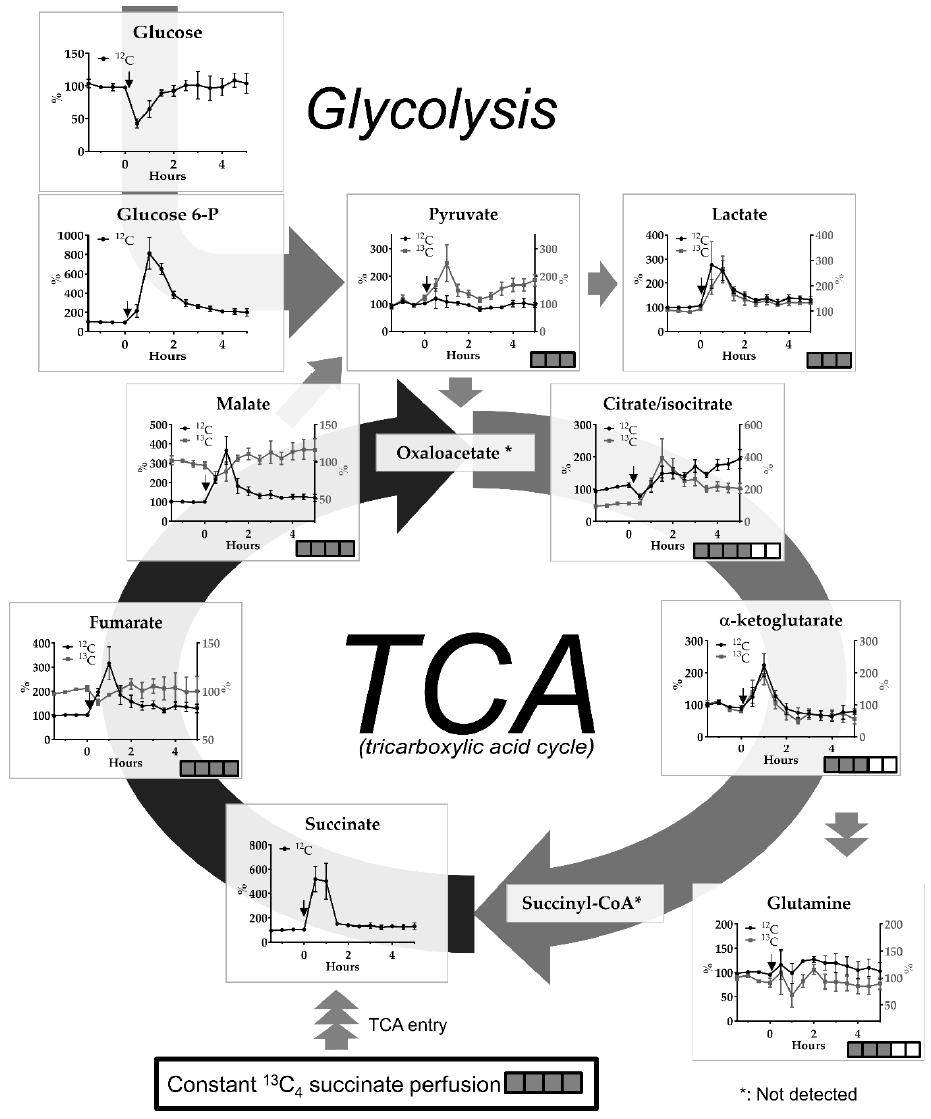
Figure 3. Effect of ET-1-induced cerebral ischemia-reperfusion on interstitial levels of endogenous ( 12 C) glucose and glucose-6-phosphate and endogenous ( 12 C) and 13 C-labeled pyruvate, lactate and TCA metabolites succinate, fumarate, malate, isocitrate, alpha-ketoglutarate and related glutamine upon constant perfusion with 1 mM 13 C 4 succinate. Data are mean +/ − SEM of 4 rats and expressed as % change of baseline abundance. Number of 13 C or 12 C atoms in the different metabolites is indicated with number of filled or open squares. Black arrows indicate time point of ET-1 infusion. * means not detected.